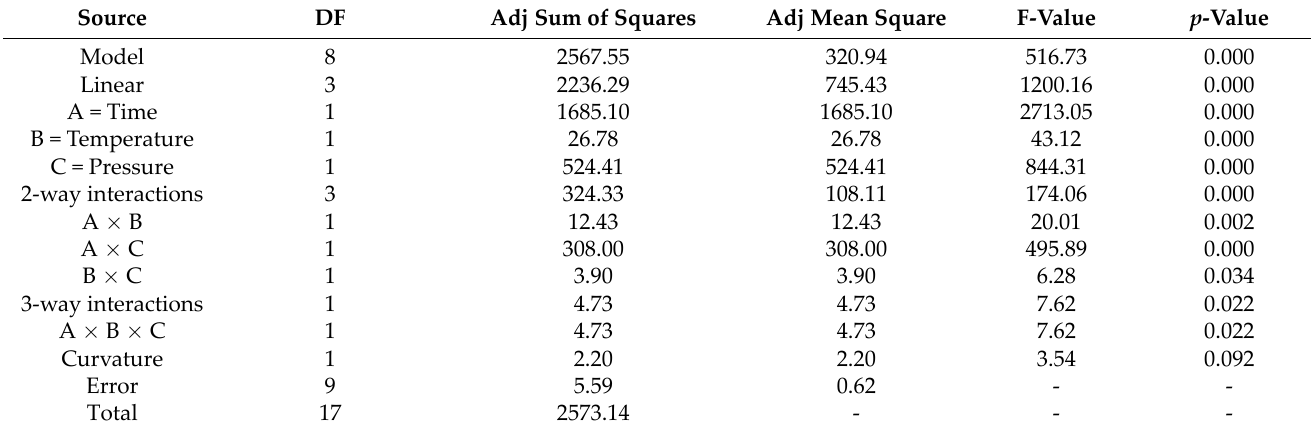
Table 2. Analysis of variance (ANOVA) of the yield of collagen/gelatin extraction from the skin.